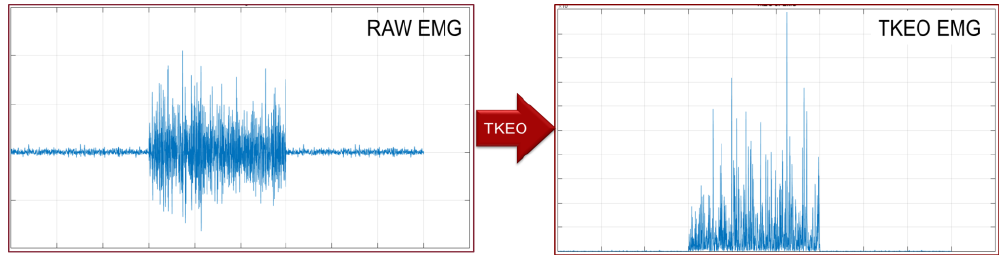
Figure 3. Raw and TKEO EMG signal, on the same time and amplitude scale.